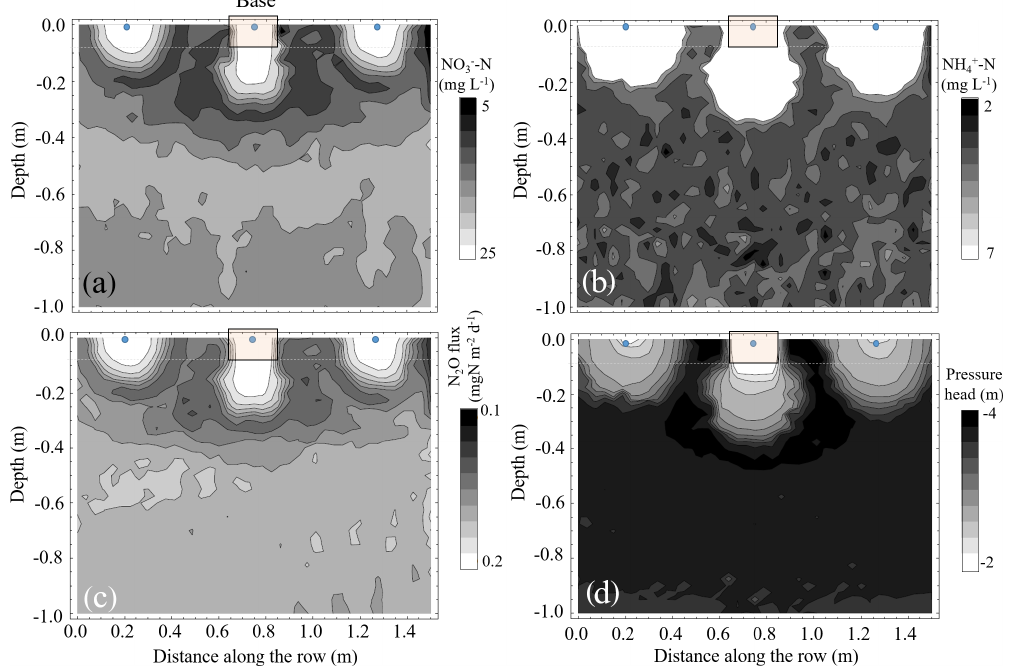
Figure 4. Contours of the simulated (a) nitrate-N (NO − -N) and (b) ammonium-N (NH + -N) concentrations, (c) vertical N 2 O flux (positive 3 4 upwards) and (d) pressure head distributions in the vertical x 1 x 3 plane of the flow domain in the vicinity of one of the dripper line laterals along one of the ridges whose center is located at x 2 = 5 . 1m (Fig. S1). The figure shows three adjacent drippers, where the center dripper is confined by a static chamber base. The presented data are a snapshot following 30d of